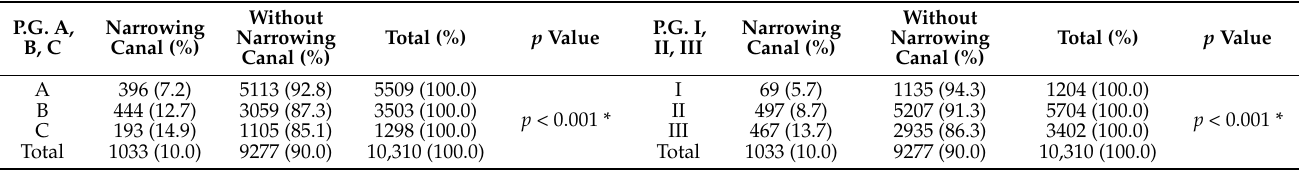
Table 6. Association between the Pell and Gregory classification and the narrowing canal in cone beam computed tomography